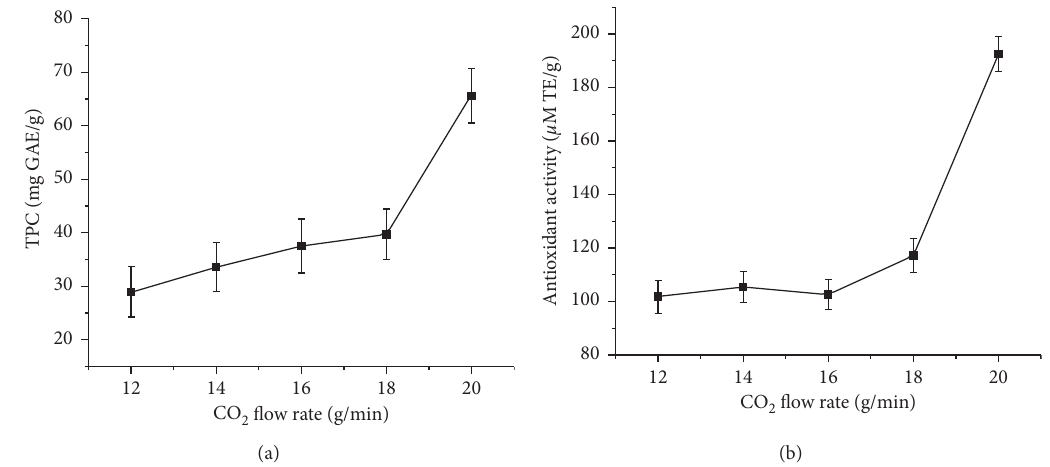
Figure 2: Effect of the CO 2 flow rate (g/min) on the (a) TPC (mg GAE/g) and (b) antioxidant activity ( μ M TE/g) of the